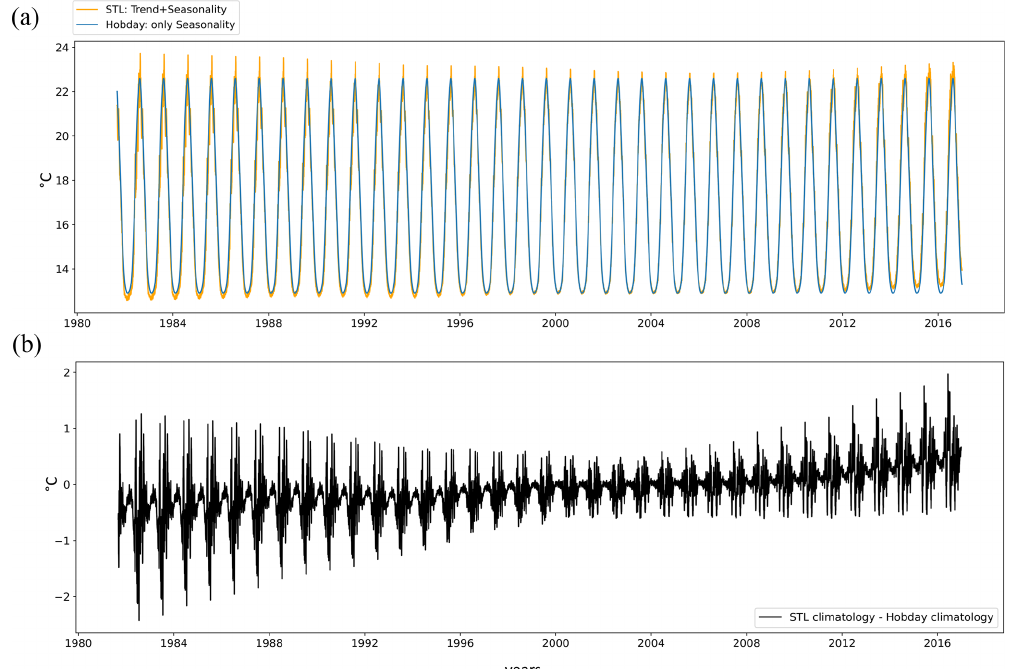
Figure 4. (a) STL mean climatology (orange line) and Hobday mean climatology (blue line) for a SST time series in the western Mediter- ranean (blue circle in Fig. 1). (b) Differences between the STL mean climatology (orange line) and Hobday mean climatology (blue line) in panel (a) .